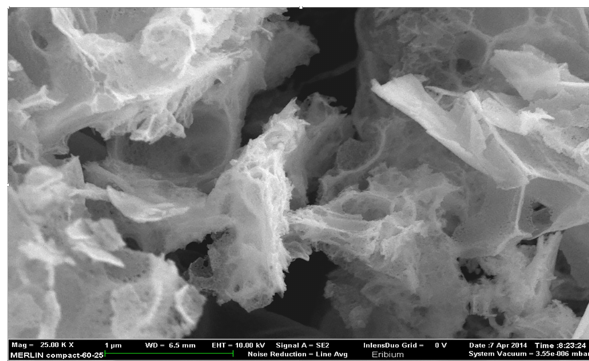
Figure 8. SEM image showing an even distribution for erbium ox- ide particles at 25000 times